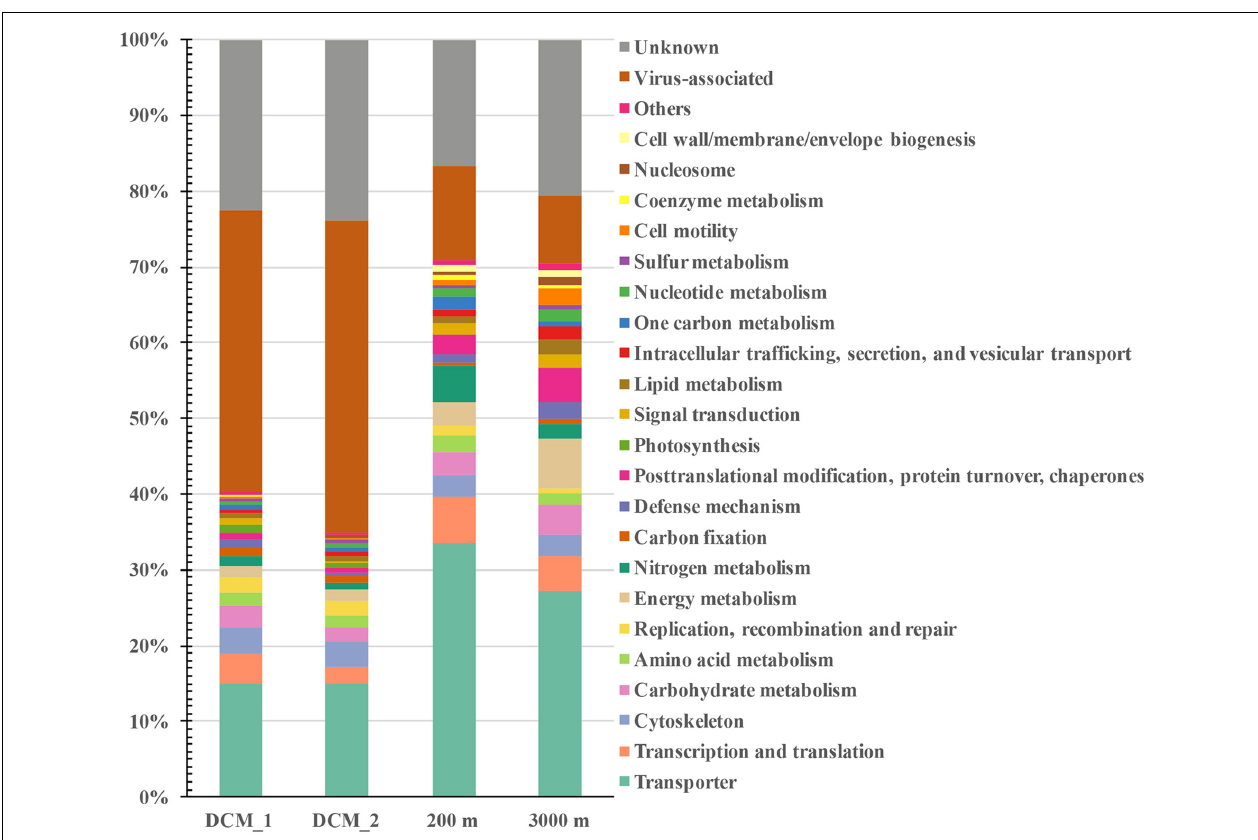
FIGURE 3 | Distribution of vertical exoprotein profiles in the SCS in terms of their functional categories. Data are represented as percentage of total relative abundance of each